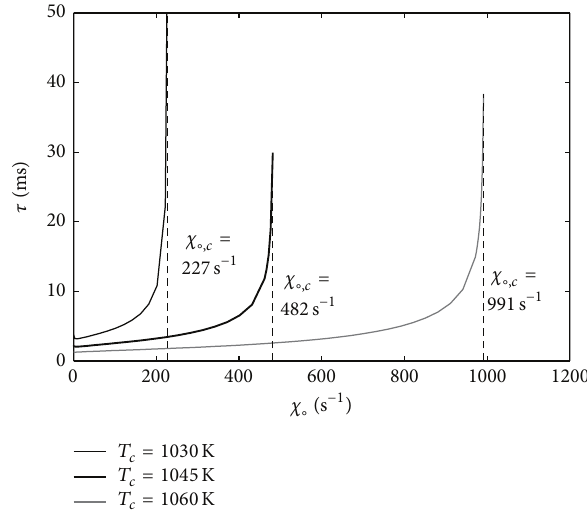
Figure 9: Ignition delays as a function of the peak scalar dissipation rate obtained using the mechanism of Mueller et al. [40] for 𝑇 𝑐 = 1030, 1045, and 1060 K. The vertical dashed lines represent the asymptotic limit beyond which ignition cannot occur ( 𝜒 ∘ = 𝜒 ∘,𝑐 ).